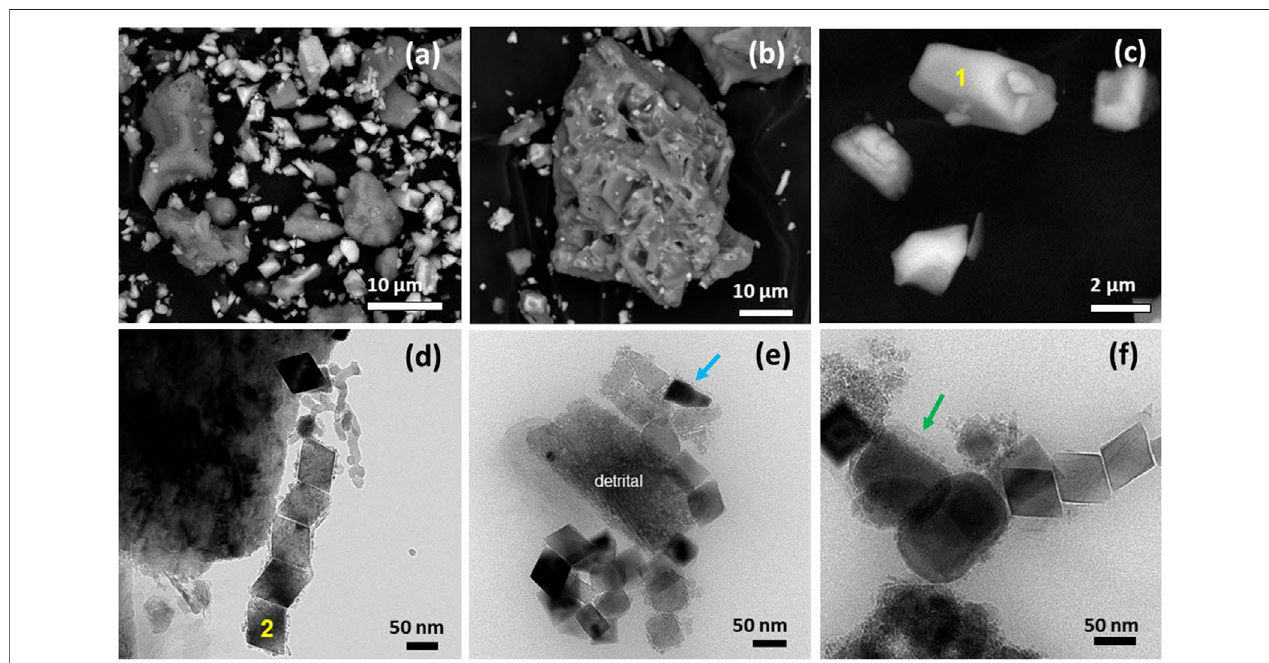
FIGURE 4 | Scanning electron microscopy (SEM) and transmission electron microscopy (TEM) images of magnetic extracts. Representative SEM images of (A) detrital grains in various sizes and morphologies; (B) volcanic grains; (C) eolian dust grains (titanomagnetite) and (D – F) TEM images of biogenic magnetite in tens of micron size. Numbers indicate EDS spots ( Supplementary Figure S3 ). In SEM backscattered images (A – C) , iron oxides show higher contrast (bright particles). Blue and green arrows show the presence of bullet-shaped and elongated prismatic biogenic magnetites.